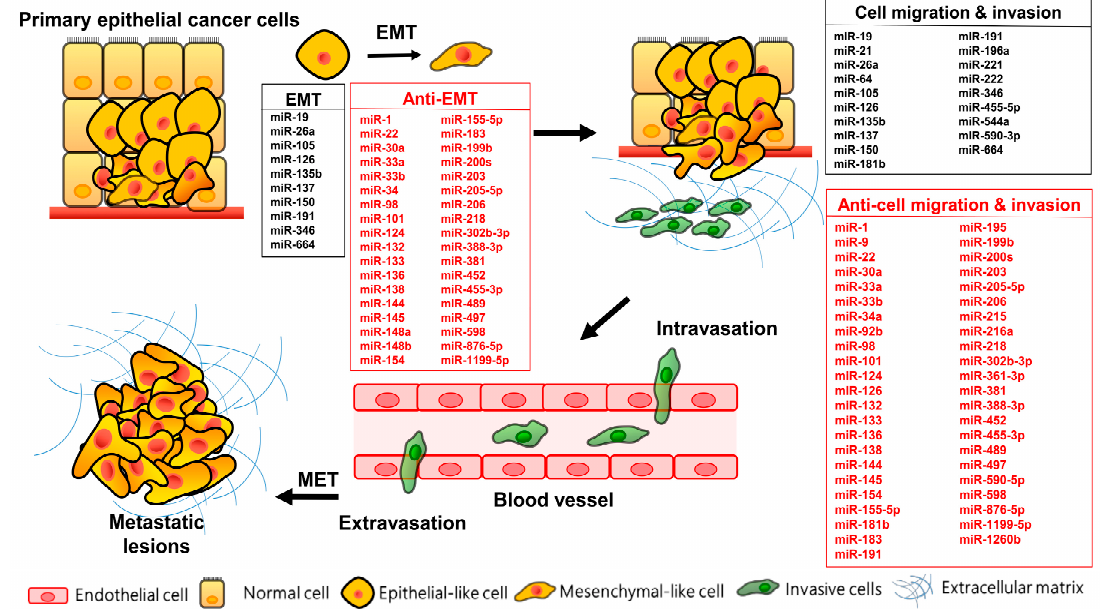
Figure 1. MicroRNAs involved in distinct steps of metastasis including EMT and migration/invasion in lung cancer. EMT: epithelial-to-mesenchymal transition; MET: mesenchymal-to-epithelial